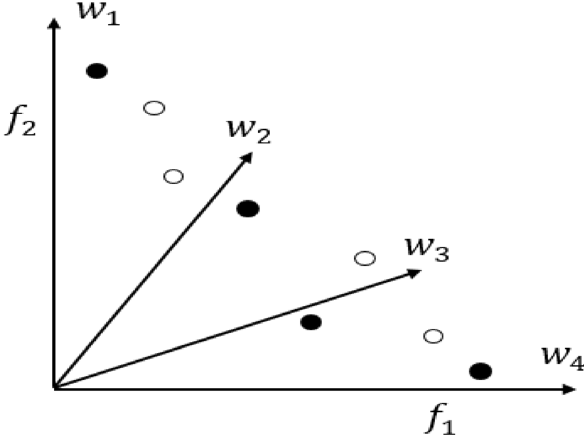
Figure 2. Illustration of the association operator using an acute